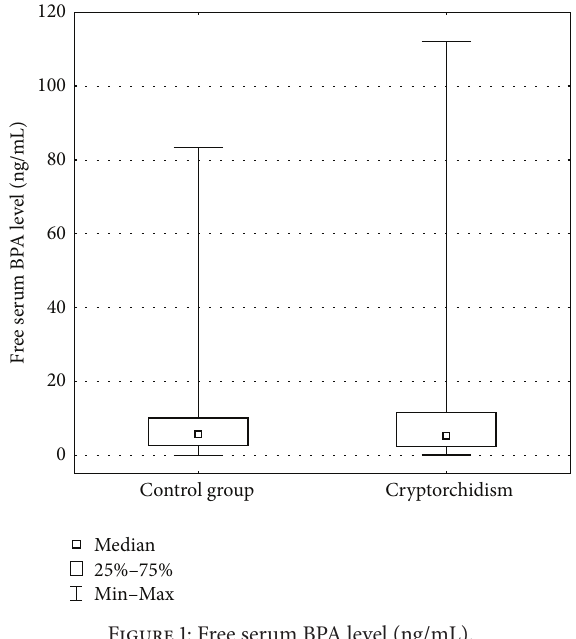
Figure 1: Free serum BPA level (ng/mL).